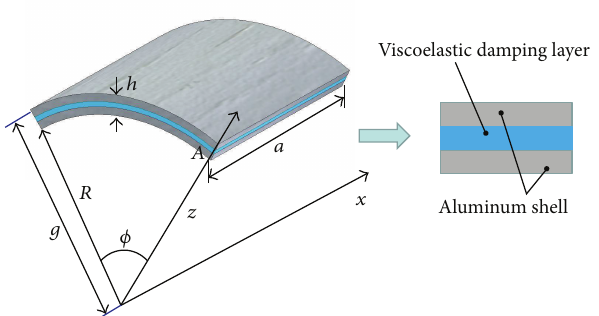
Figure 2: In-plane displacement based on the layerwise